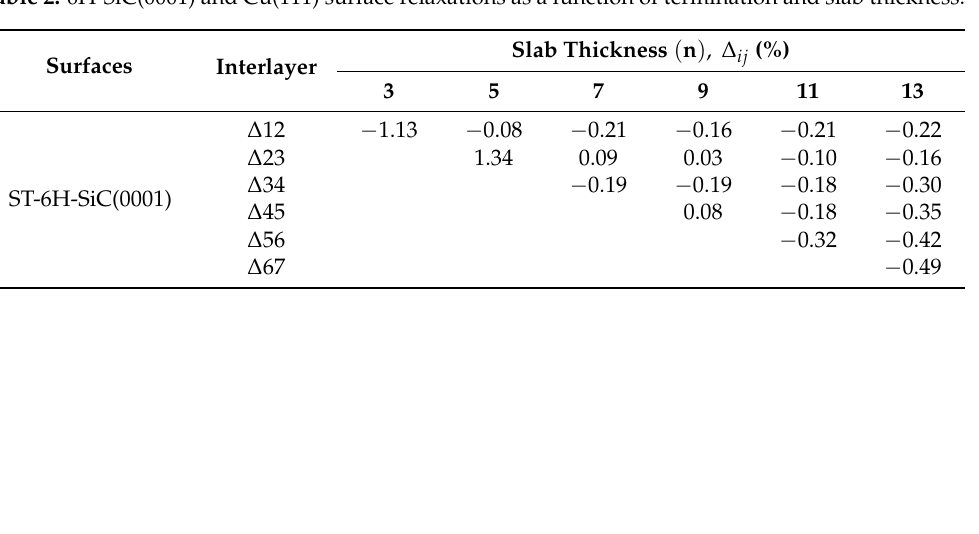
Table 2. 6H-SiC(0001) and Cu(111) surface relaxations as a function of termination and slab